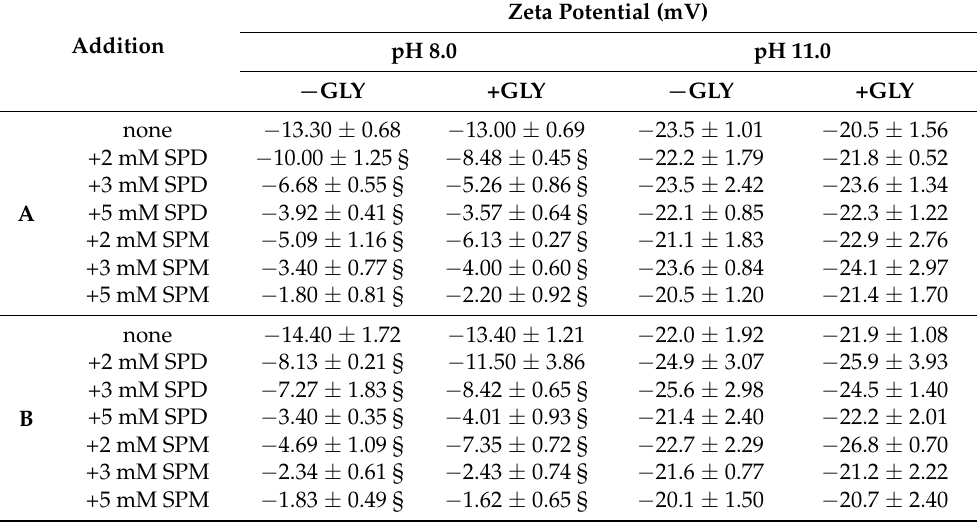
Table 1. Effect of different concentrations of polyamines (PAs) on 25 ◦ C-treated ( A ) or 80 ◦ C-treated ( B ) BVPC FFSs zeta potential measured at either pH 8.0 or 11.0 in the absence and presence of 42 mM GLY *.